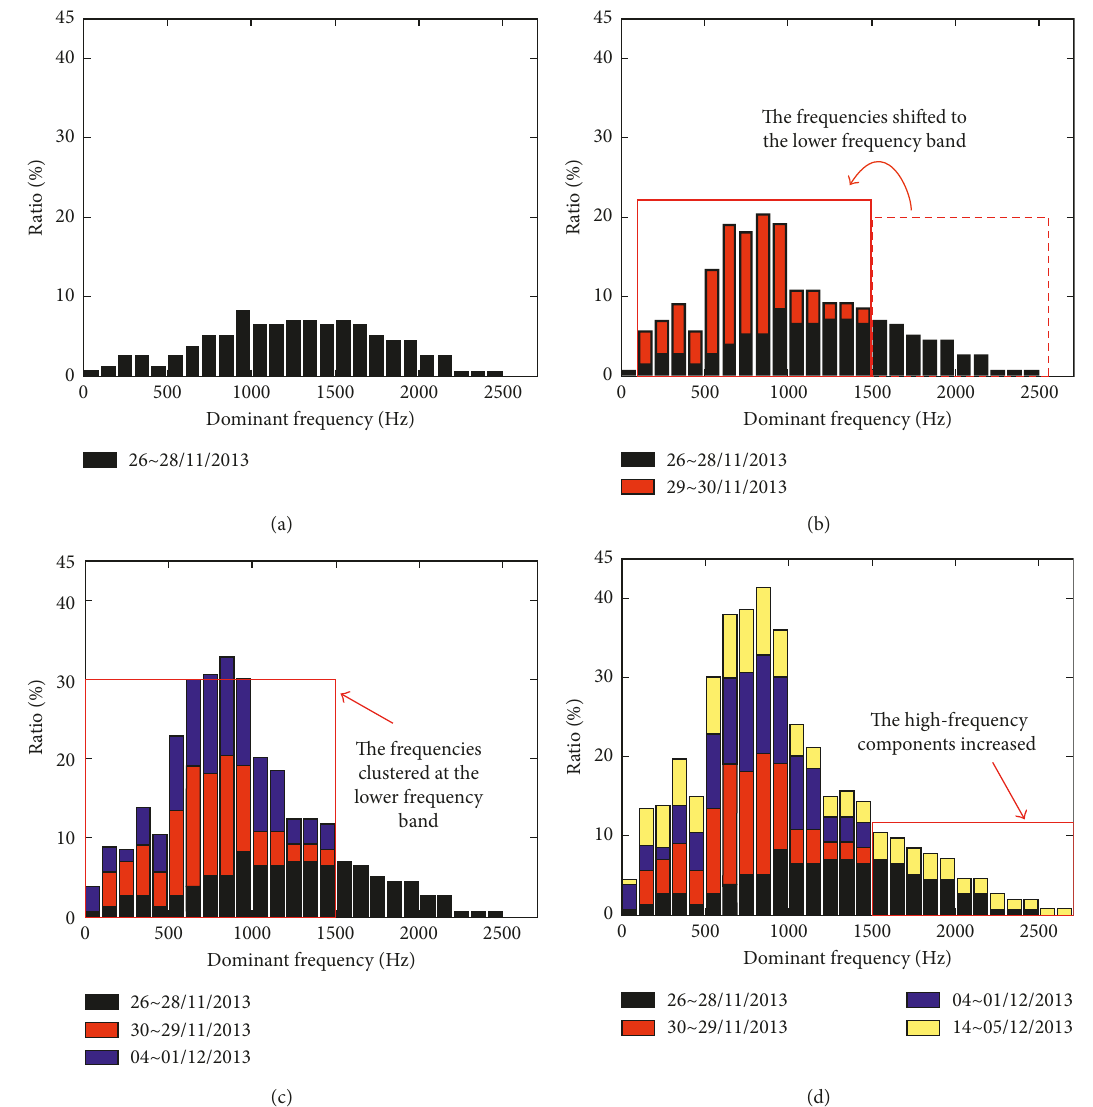
Figure 8: The accumulative variation of dominant frequency of MS signals: (a) date time: 26/11/2013 ∼ 27/11/2013, (b) date time: 26/11/2013 ∼ 30/11/2013, (c) date time: 26/11/2013 ∼ 4/12/2013, and (d) date time: 26/11/2013 ∼